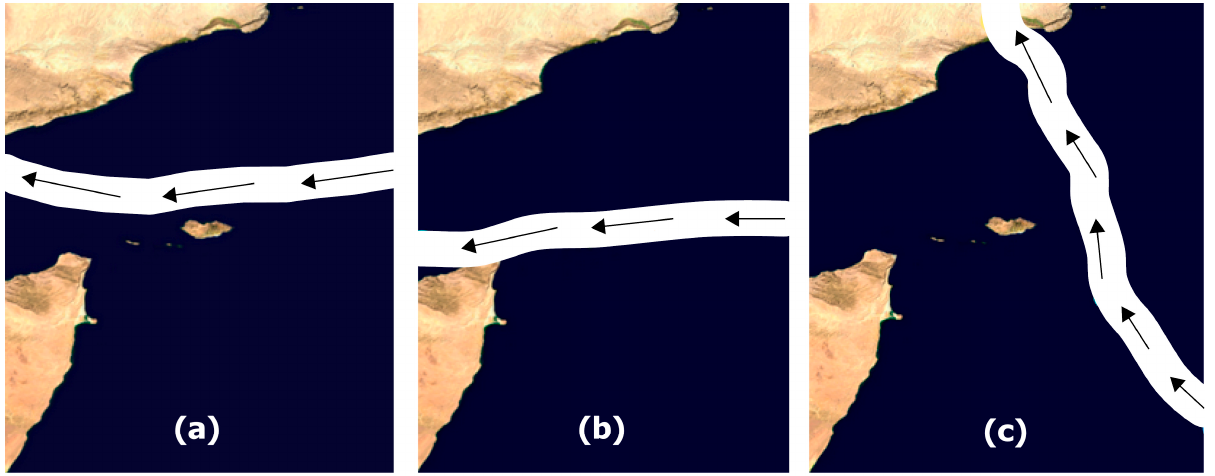
Figure 13. From left: Chapala ( a ) and Megh ( b ), both hitting Socotra Island in 2015, and the Mekunu ( c ) cyclone, which passed in 2018. Redrawn after [32].